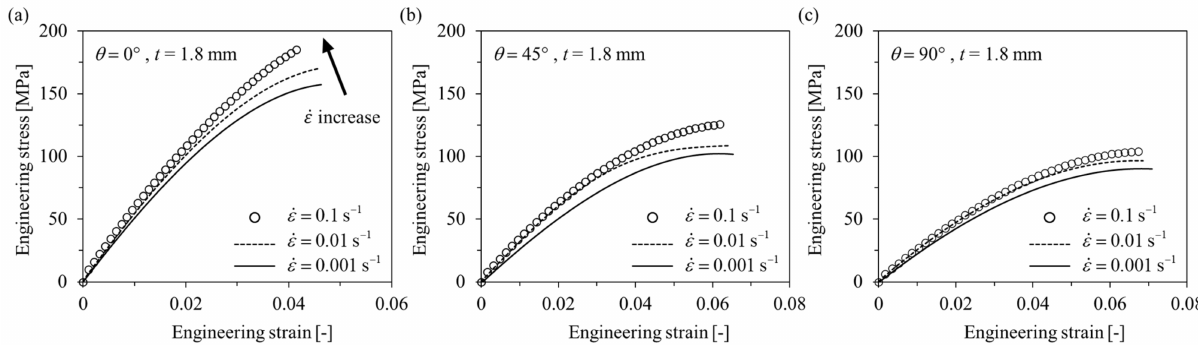
Figure 5. Tensile engineering stress–engineering strain curves of t = 1.8 mm specimens with different strain rates. ( a ) θ = 0 ◦ , ( b ) θ = 45 ◦ , ( c ) θ = 90 ◦ .